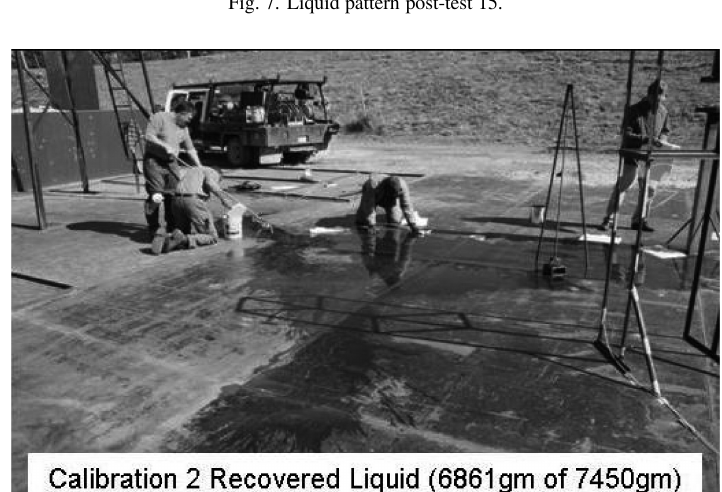
Fig. 7. Liquid pattern post-test 15.